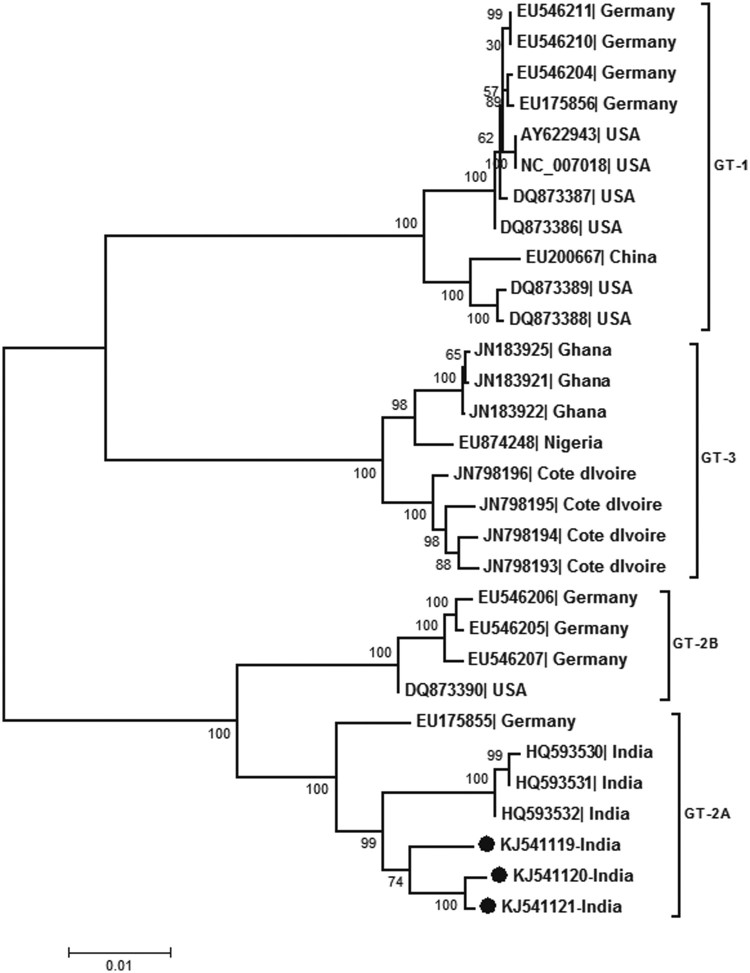
Phylogenetic analysis of almost full genomes sequenced during this study (accession numbers KJ541119, KJ541120 and KJ541121). Full genome sequences available in the Genbank database are denoted by the respective accession numbers. Percent bootstrap support is indicated at each node. Genotypes are designated as brackets. Solid circles denote sequences obtained during the present study. Scale bar indicates nucleotide substitutions/site.